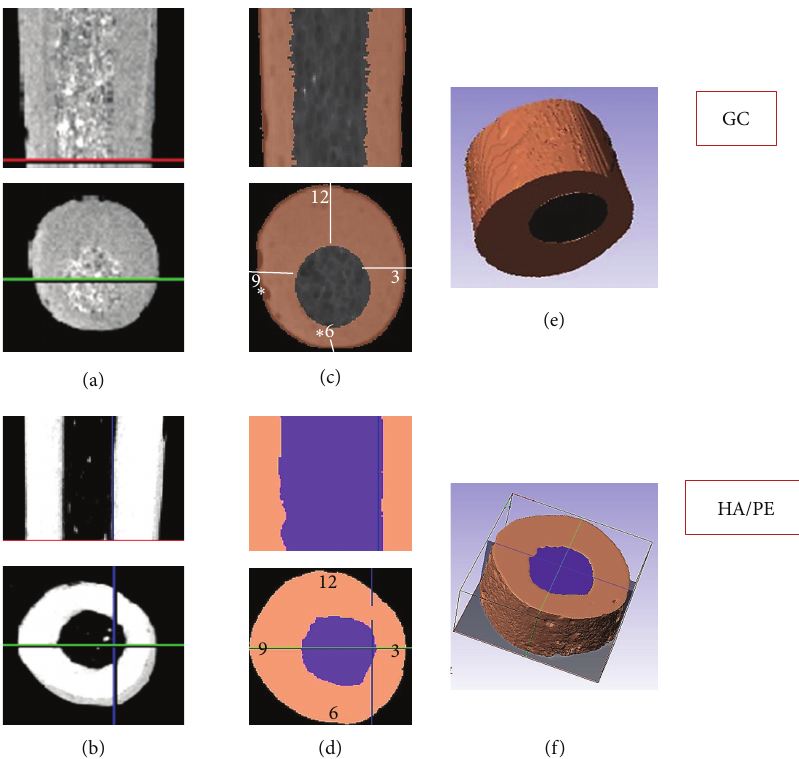
Figure 2: Microcomputed tomography images prepared from the middle third of the GC and HA/PE obturators. (a, b) 𝜇 CT scans of the GC and HA/PE systems, respectively, showing slice selection from the middle third. (c, d) 𝜇 CT slices of GC and HA/PE, respectively, segmented by Scan IP using different masks. (e, f) 3D reconstruction of GC and HAPE systems using Scan IP based on voxel density.